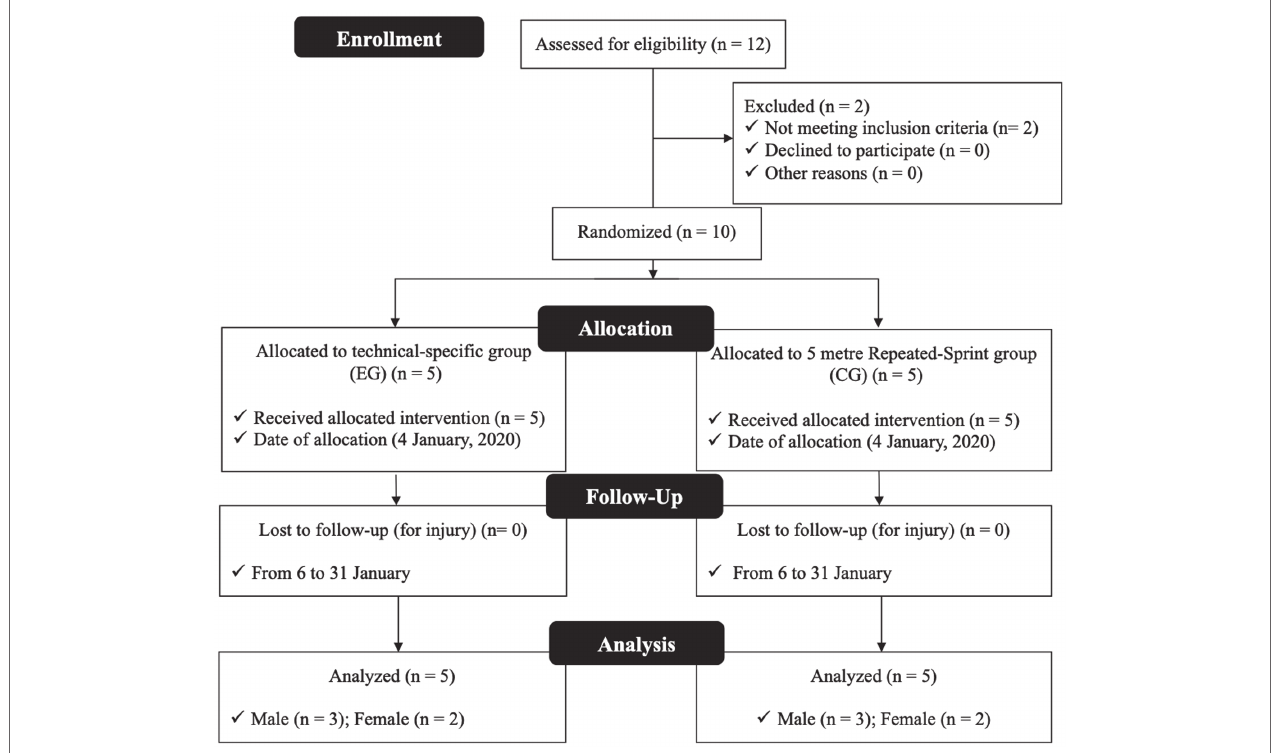
FIGURE 1 | Flow chart of the process followed in the